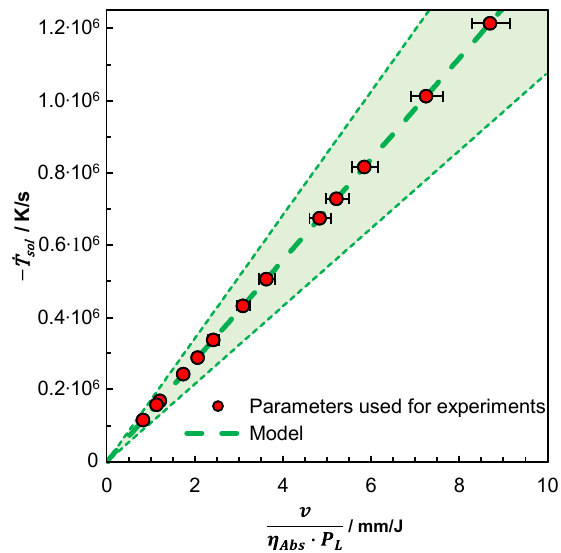
Figure 4. Cooling rate according to Equation (9). The green shaded area illustrates the uncertainty